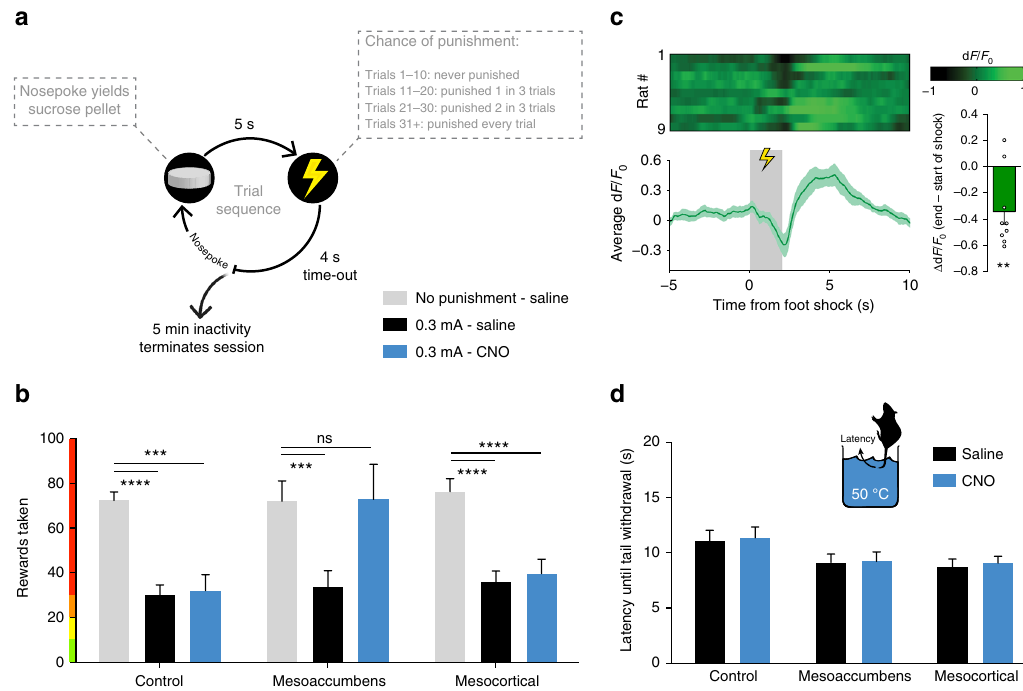
Fig. 6 Mesoaccumbens but not mesocortical activation attenuates the effect of punishment on responding for sucrose. a Task design. b After saline treatment, foot shock punishment robustly diminished responding (Sidak ’ s multiple comparisons test, ‘ 0.3 mA saline ’ versus ‘ no punishment saline ’ , all p < 0.001). This effect was abolished by activation of the mesoaccumbens, but not the mesocortical, pathway (Sidak ’ s test, ‘ 0.3 mA CNO ’ versus ‘ no punishment saline ’ in the mesoaccumbens group, p = 0.9995; in mesocortical group, p = 0.0002; in control group, p < 0.0001); n = 9 control, n = 9 mesoaccumbens group, n = 10 mesocortical group. c Foot shock punishment evoked a decrease in DA neuron activity, measured using fi ber photometry in TH::Cre rats (one-sample t -test, p = 0.0074, n = 9 rats). d No modulation of nociception by mesoaccumbens or mesocortical activation in the tail group, n = 9 mesocortical group. Data are shown as mean ± standard error of the mean; ns not signi fi cant, **** p < 0.0001, *** p <